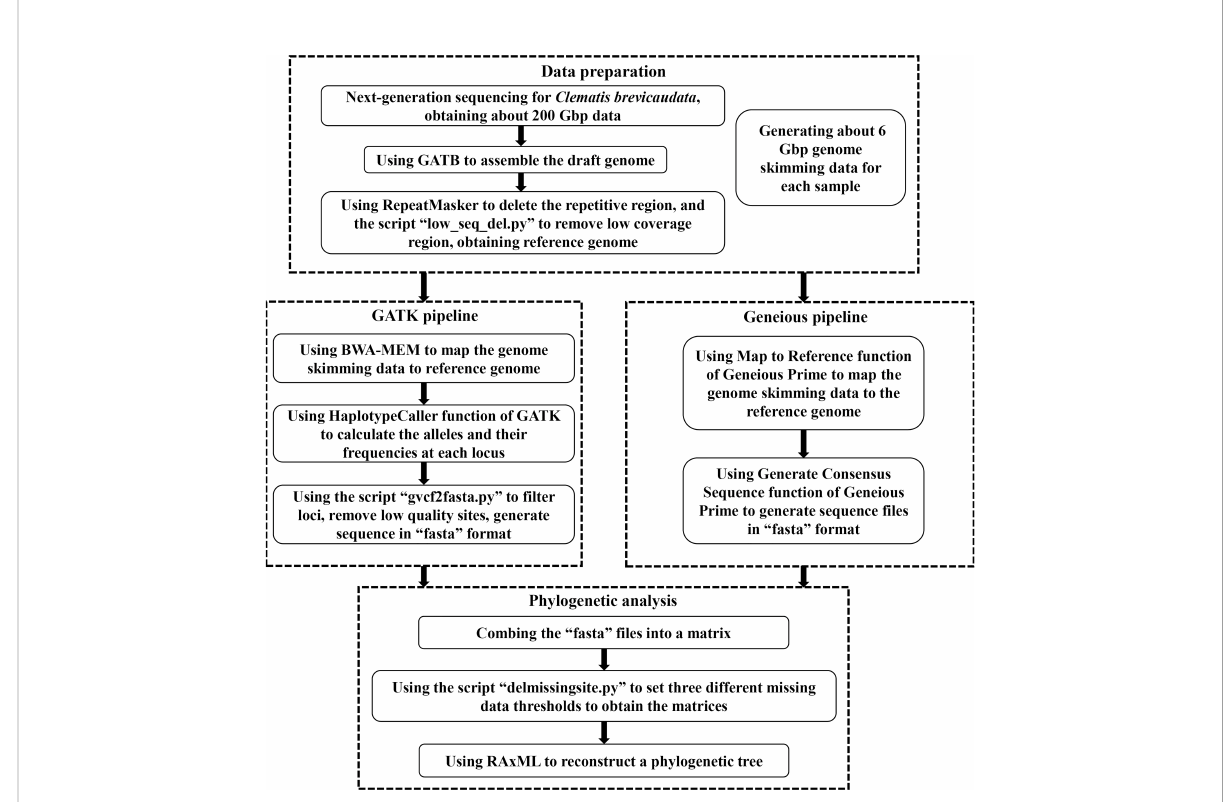
FIGURE 1 A fl ow chart of acquiring nuclear single nucleotide polymorphisms (SNPs) dataset from genome skimming data in this